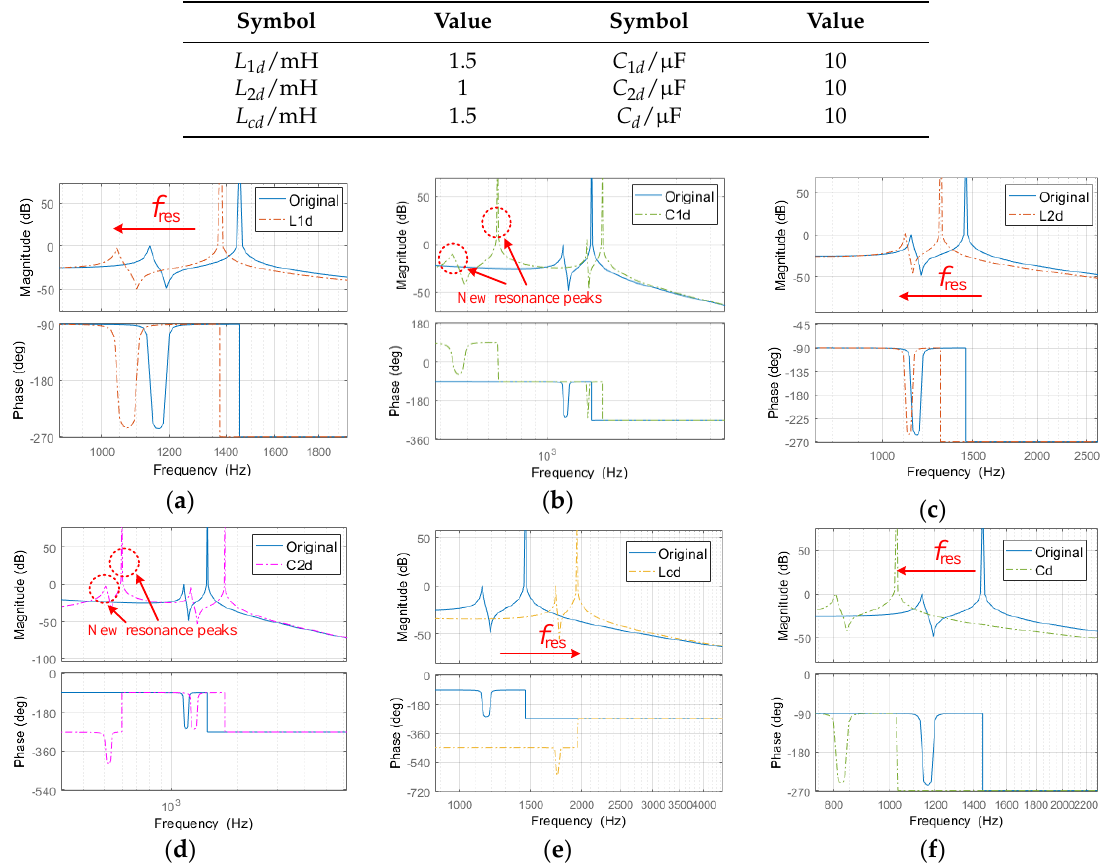
Figure 11. Virtual impedance bode diagrams of G o_m : ( a ) L 1 d ; ( b ) C 1 d ; ( c ) L 2 d ; ( d ) C 2 d ; ( e ) L Cd ; ( f ) C d .